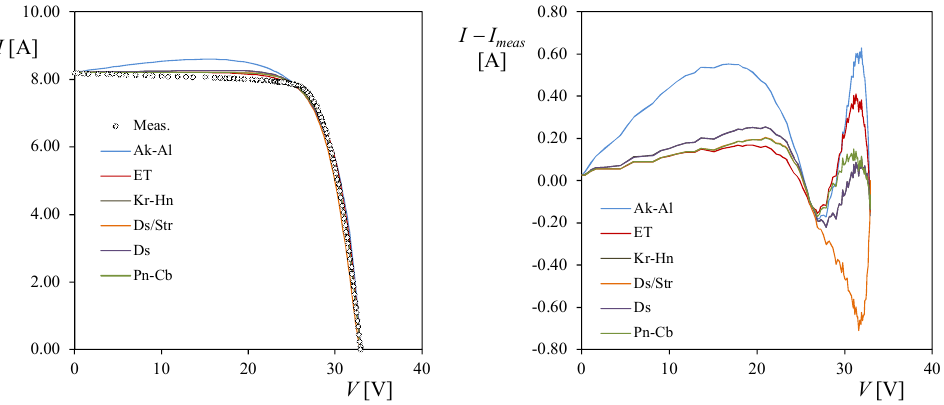
Figure 9. Curves for the explicit models analyzed, fitted to the Photowatt KC200GT-2 solar panel data using the analytical methods proposed; see Section 2 ( left ). The error in relation to the data is also included in the figure ( right ).